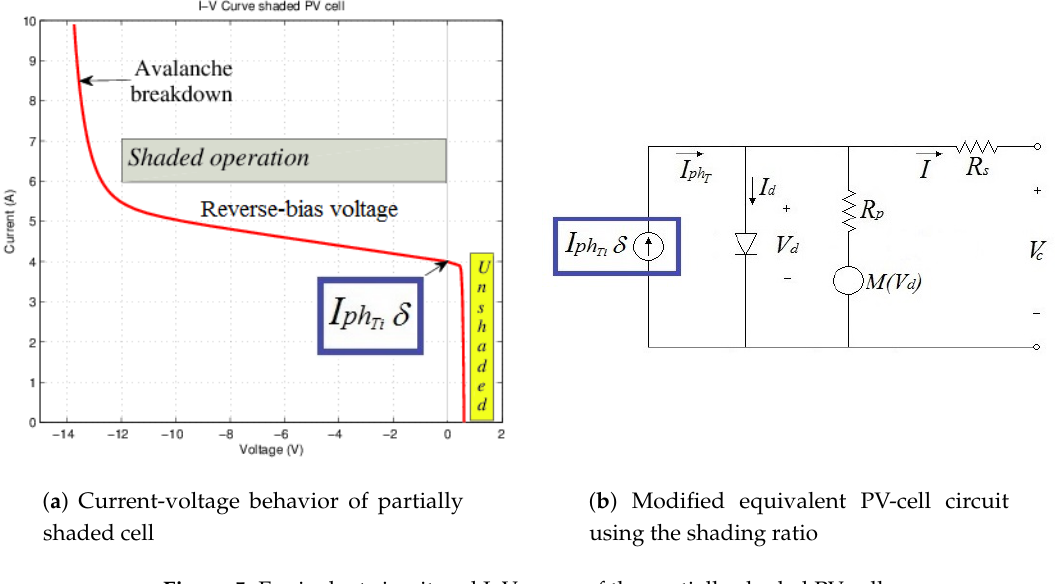
Figure 5. Equivalent circuit and I–V curve of the partially shaded